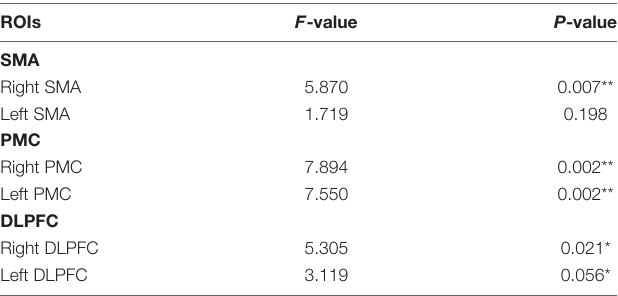
TABLE 4 | The result of repeated measure ANOVA for the beta values of ROIs during Baseline, Post-task 1 and Post-task 2. ROIs F -value P -value SMA Right SMA 5.870 0.007** Left SMA 1.719 0.198 PMC Right PMC 7.894 0.002** Left PMC 7.550 0.002** DLPFC Right DLPFC 5.305 0.021* Left DLPFC 3.119 0.056*